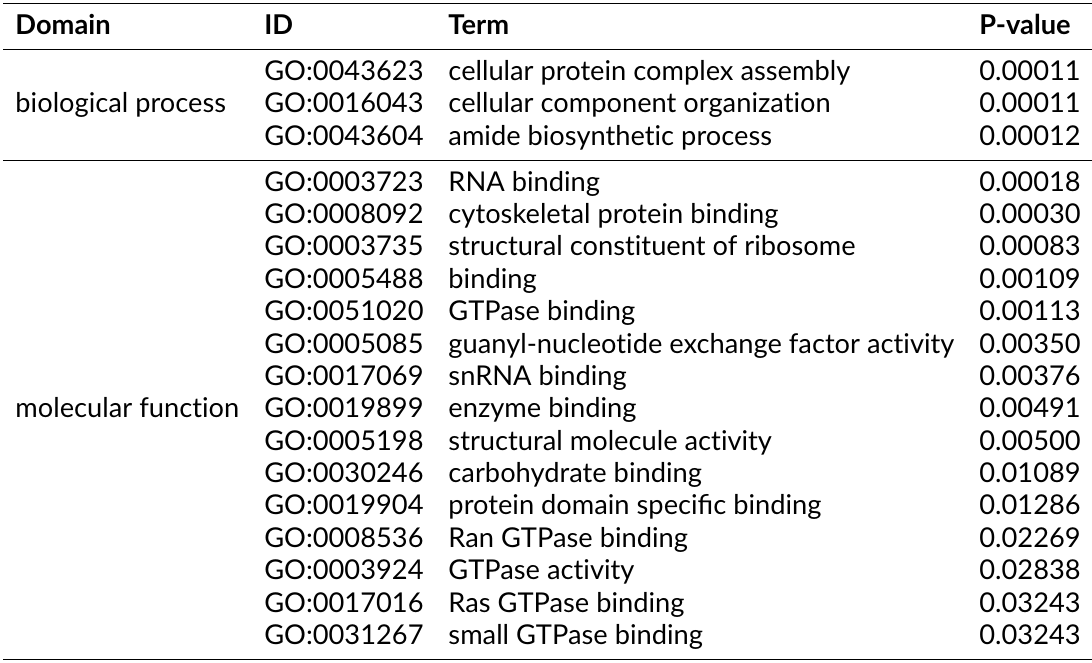
Table S4 – GO terms enriched in genes supporting an intensification of selection in eusocial Hymenoptera. P-values are those of a Fisher hypergeometric test used for sig- nificance in the GO enrichment analysis, as implemented in the R package topGO (Alexa and Rahnenfuhrer, 2020).